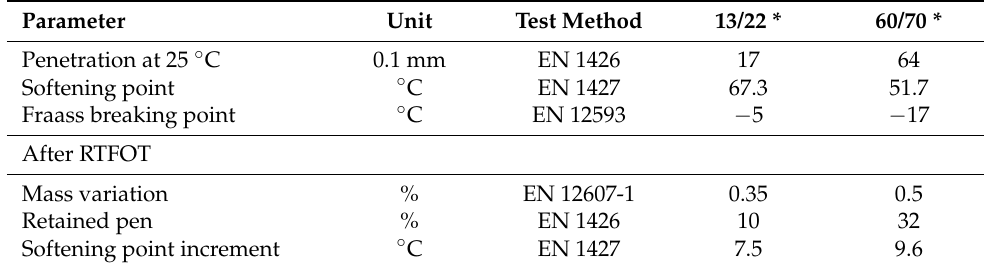
Table 1. Properties of 13/22 and 60/70